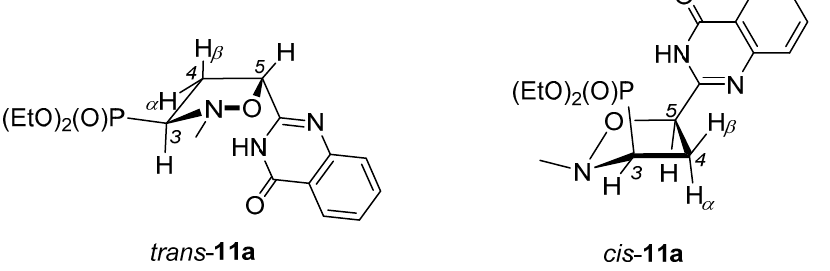
Figure 2. The preferred conformations of trans-isoxazolidine trans - 11a .